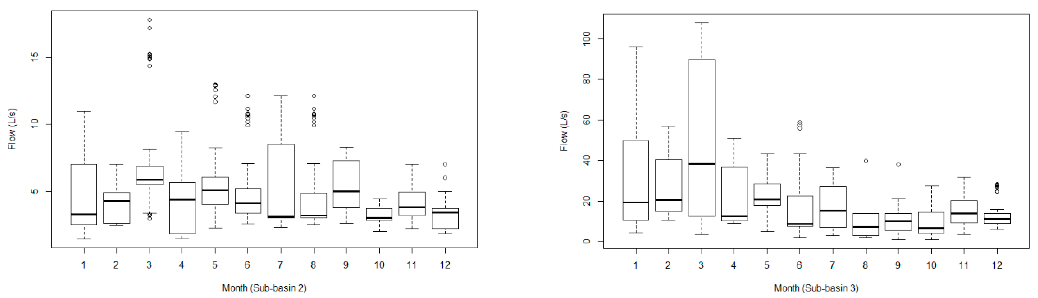
Figure 7. Sub-basins 1.1 and 1.2 discharge flow in the Olaria stream watershed, State of São Paulo, Brazil.